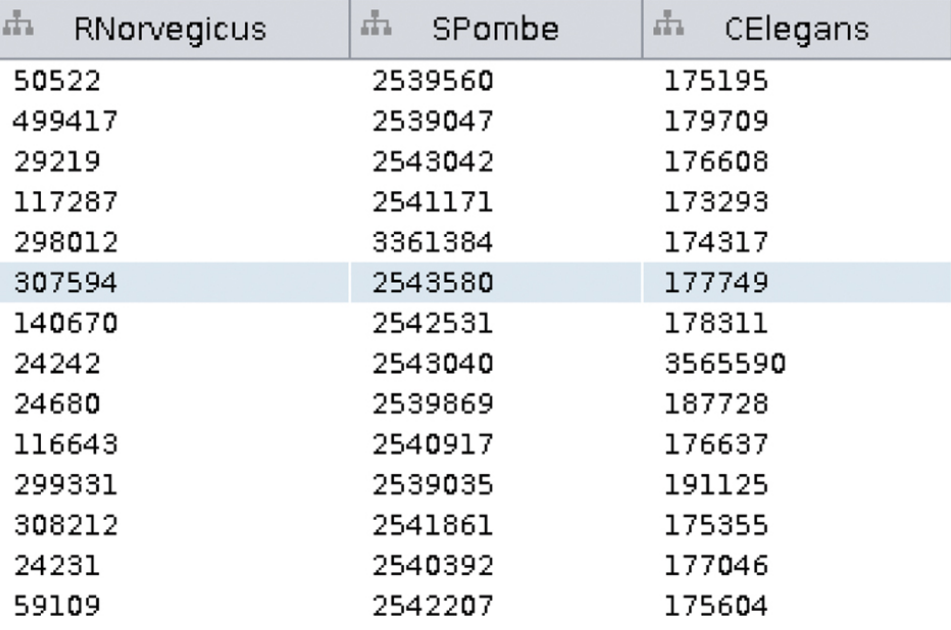
Figure 4: Table of aligned nodes from alignment of three